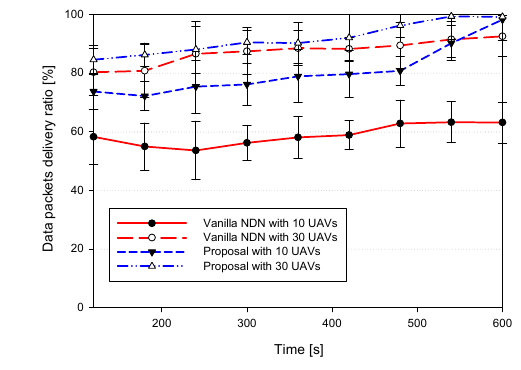
Figure 9. Security-related performance of both NDN and our proposal.